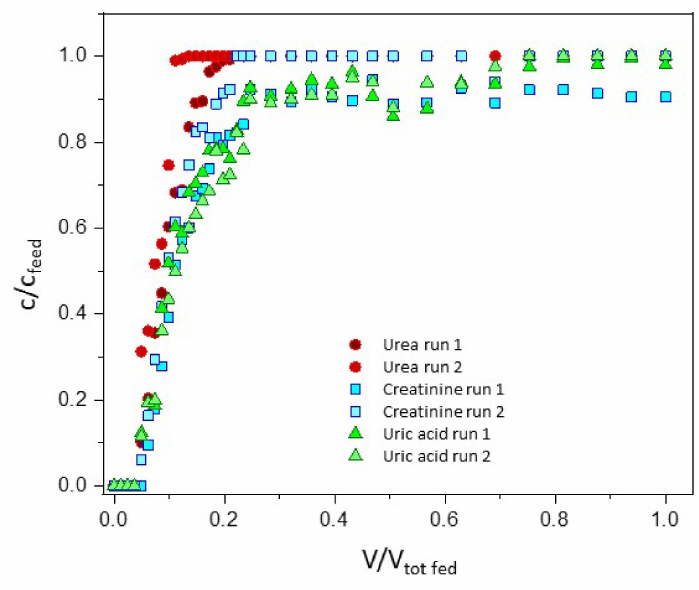
Figure 8. Breakthrough curves of urea, creatinine and uric acid for the MMMAs cartridge in contact with a mixture of toxins at 0.5 mL/min.